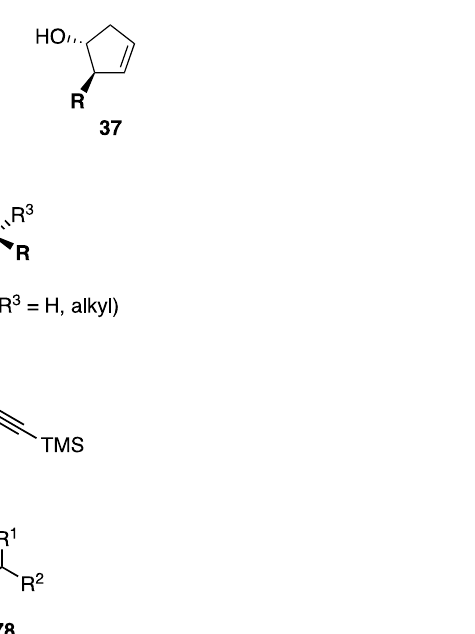
Scheme 18. C–C bond forming reactions at secondary carbons.